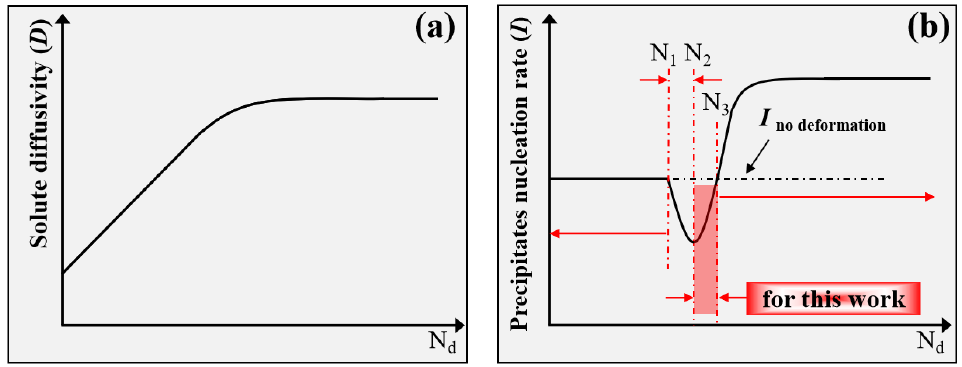
N ) on solute atoms diffusion of precipitate; ( b ) the Figure 12. ( a ) The effect of dislocation density ( Figure 12. ( a ) The effect of dislocation density ( N d ) on solute atoms diffusion of precipitate; ( b ) the d N ) on nucleation of precipitate. effect of dislocation density ( effect of dislocation density ( N d ) on nucleation of d